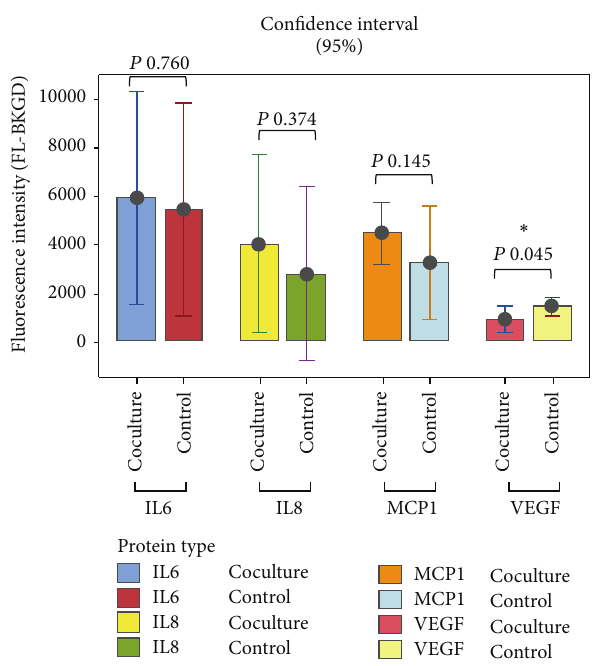
Figure 8: Concentration of cytokines released by htMSCs before (control) and after coculture with murine 4T1 tumor cells (with no direct contact). A small increase (about 9%) of IL6, an important increase of IL-8 and MCP1 (about 45% and 37%, resp.), and a decrease of VEGF expression (about 36%) were observed ( 𝑃 = 0.045 ). All samples were analyzed in triplicate. The results represent the mean and standard deviation of each